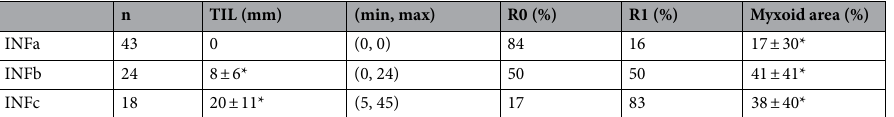
Table 2. Tail-like infiltration length (TIL), resection margin assessment (R0, negative; R1, positive), and percentage of myxoid area for INFa, INFb, and INFc cases. TIL Tail-like infiltration length. *Values are means ±